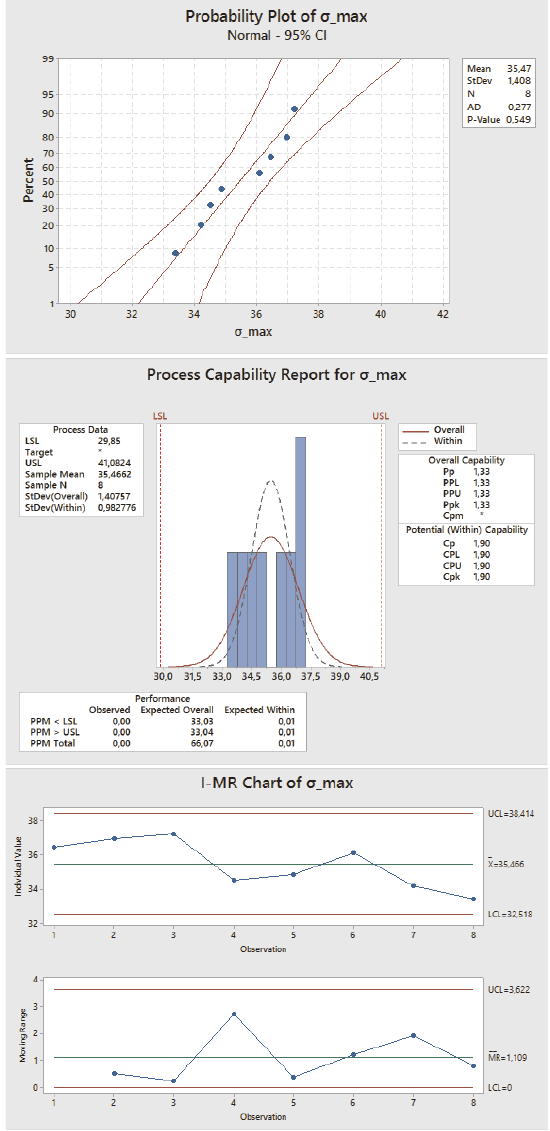
Figure 24: Probability Plot, Process Capability Report and I-MR Chart for the maximum stress at rupture ( σ max ) of specimens.